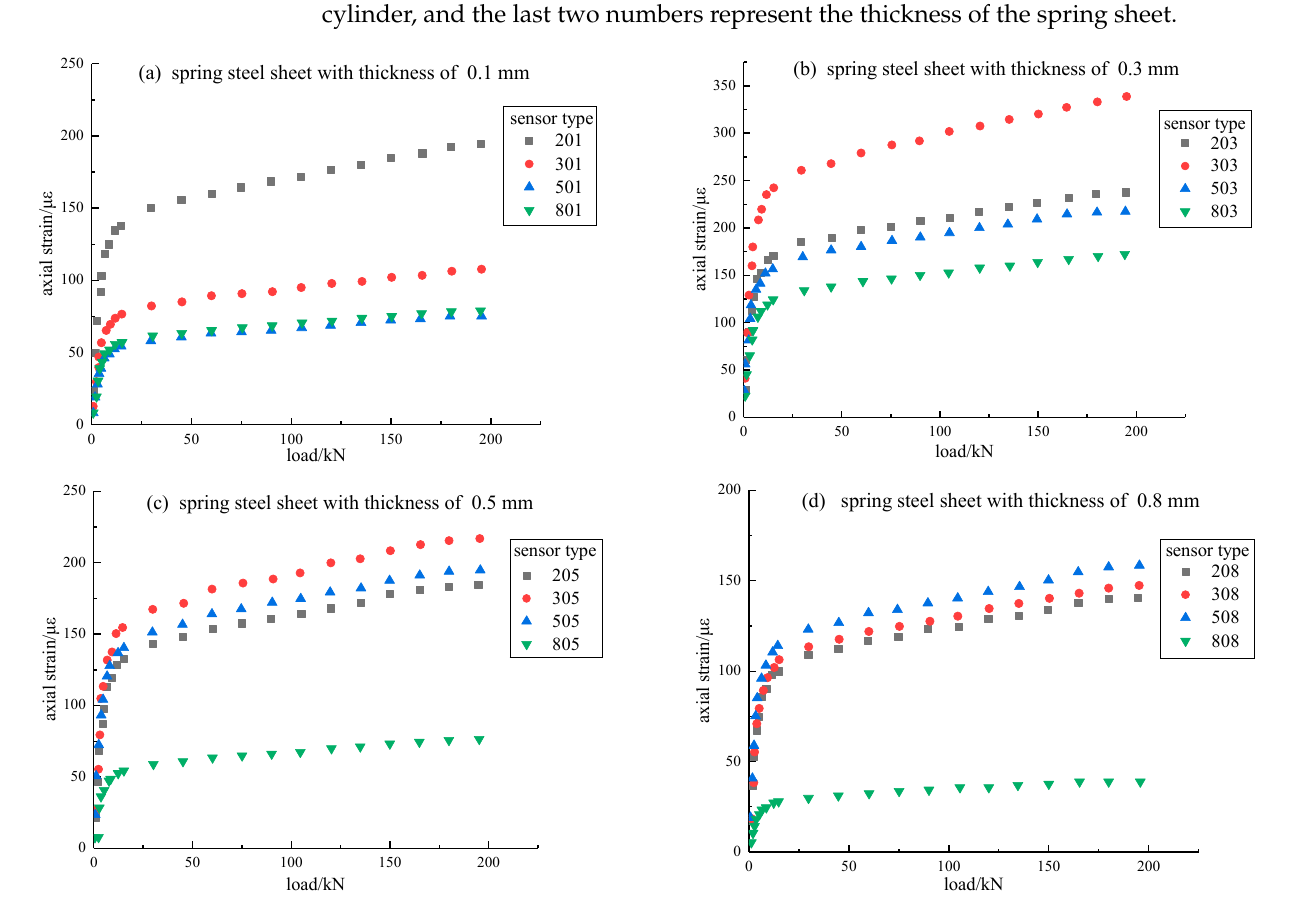
Figure 9. Relationship between combined load and strain with different thicknesses.